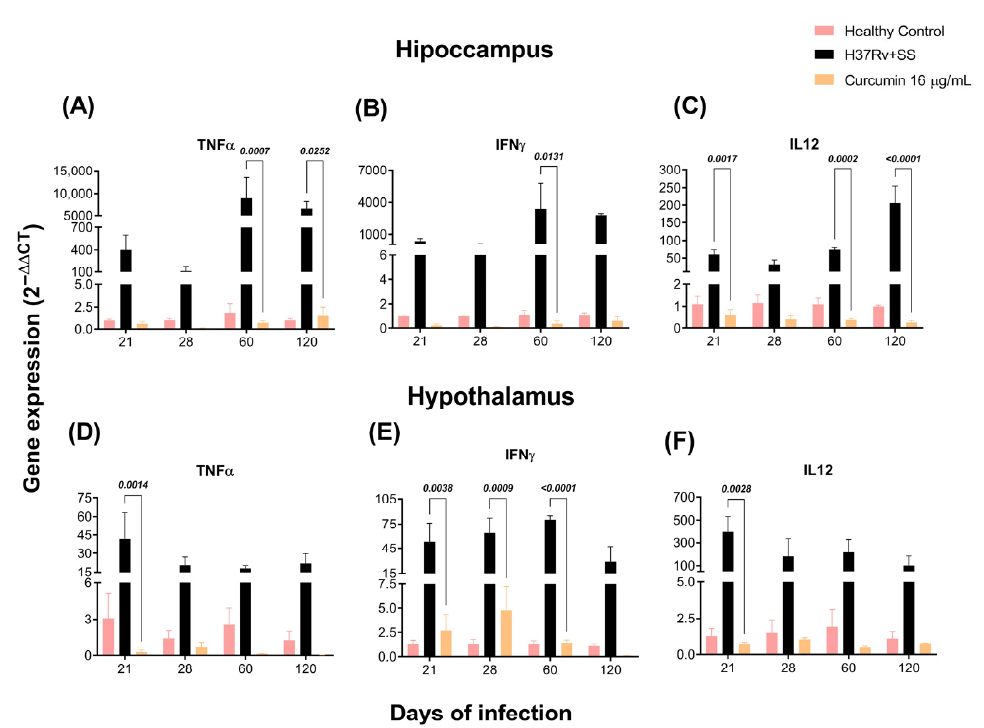
Figure 3. Effect of curcumin (CUR) treatment (16 µ g/mL) on pro-inflammatory cytokines of the hippocampus and hypothalamus of mice infected with 2.5 × 10 5 Mtb virulent strain H37Rv colony- forming units (CFU), mice that received saline solution (SS) as vehicle and mice that were not infected and were used as controls. ( A ) TNF α expression on the hippocampus. F (2, 6) = 7.327, p =